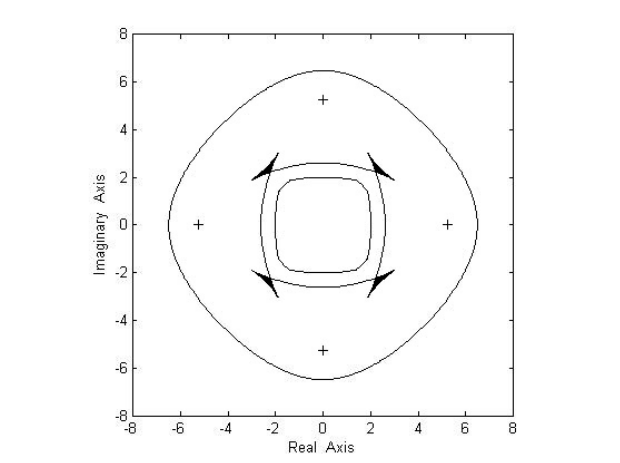
Figure 1. The three curves with their interior (from outside inside) depict the sets